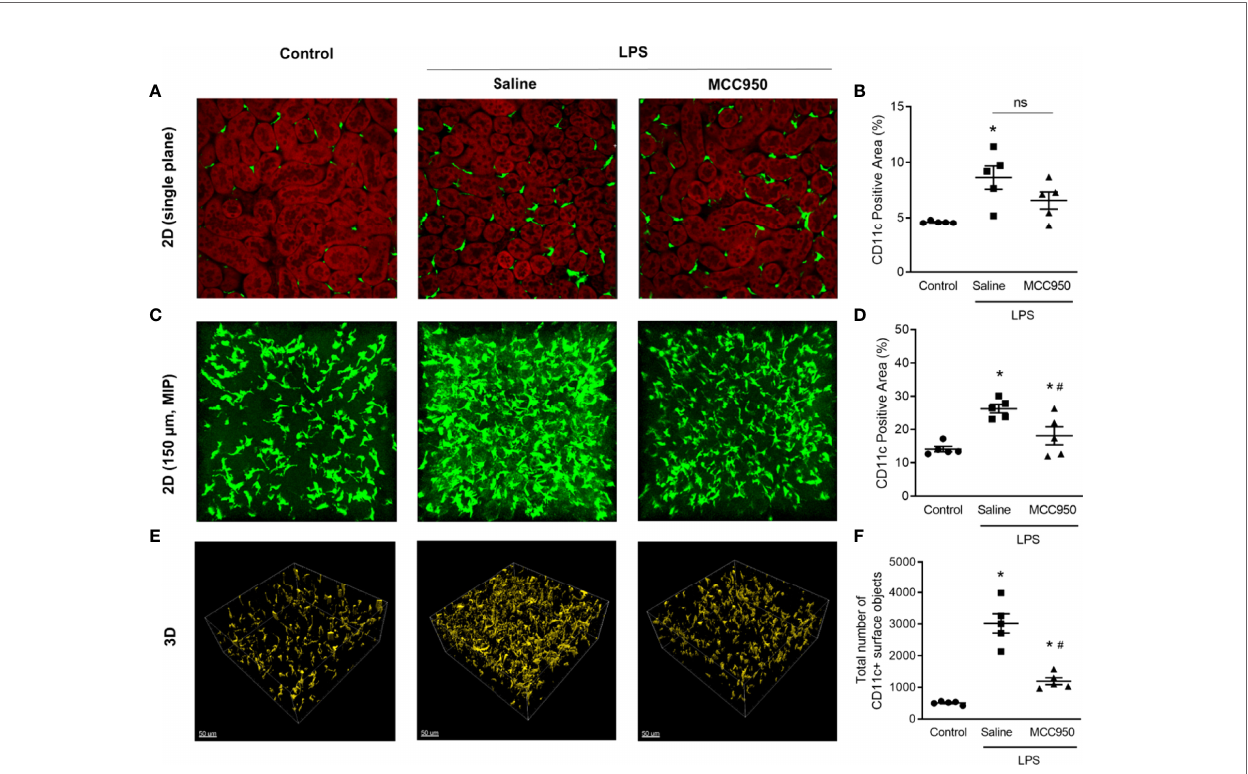
FIGURE 3 | Three-dimensional visualization and quanti fi cation of CD11c+ MNPs with MPM. (A) Two-dimensional single plane images. The red signals indicate the auto fl uorescence of tubular cells. (B) Areas of CD11c+ cells in single plane images. (C) MIP images. (D) Areas of CD11c+ cells in MIP images. (E) Three-dimensional images. (F) The number of CD11c+ cells in 3D images. The total cell number was counted per fi eld of view. Data are represented as the mean ± SEM (n=5 per group). * P <0.05 versus the normal control, # P <0.05 versus the saline-treated LPS group. ns, nonsigni fi cant; MIP, maximum intensity